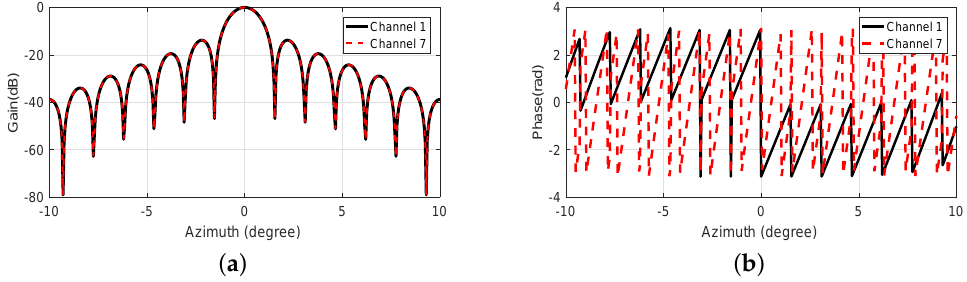
Figure 7. Antenna pattern. ( a ) Envelope information; ( b ) Phase information.